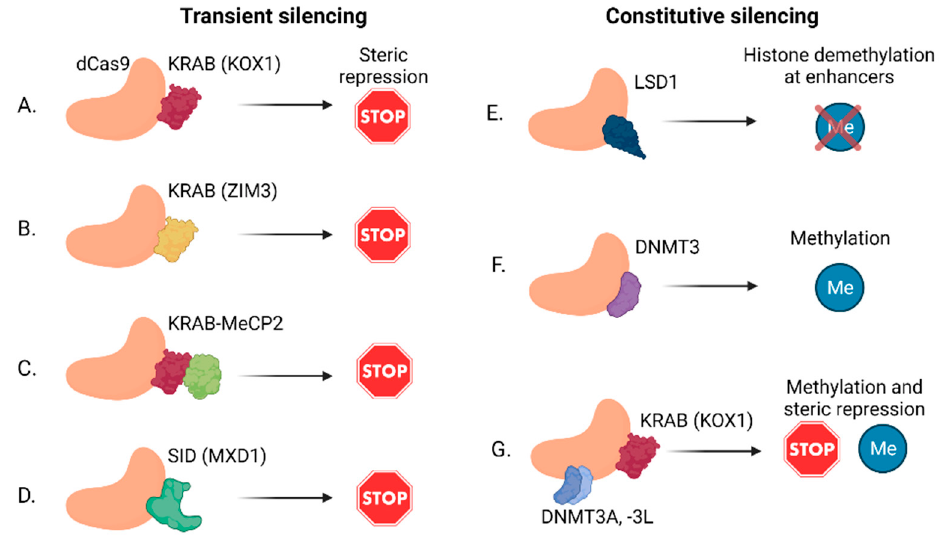
Figure 3. Different approaches for efficient transient ( A – D ) or constitutive ( E – G ) gene silencing using CRISPRi. ( A ) dCas9 fused to the KRAB domain of KOX1. ( B ) dCas9 fused to the KRAB domain of ZIM3. ( C ) dCas9 fused to KOX1 KRAB and MeCP2. ( D ) dCas9 fused to the SID domain of MXD1. ( E ) dCas9 fused to DNMT3 leading to DNA methylation at the target site. ( F ) dCas9 fused to LSD1 leading to histone demethylation at enhancer regions. ( G ) CRISPR-off, comprising dCas9 fused to KOX1 KRAB and DNMT3A and -3L. (Created with BioRender.com (accessed on 12 December 2021)).